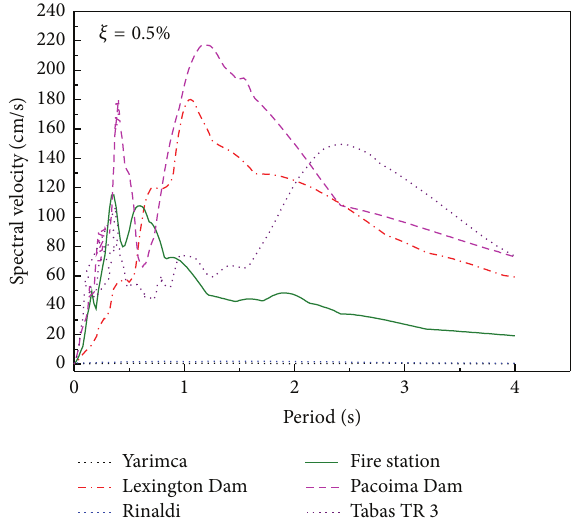
Figure 11: Velocity spectra of near-fault ground